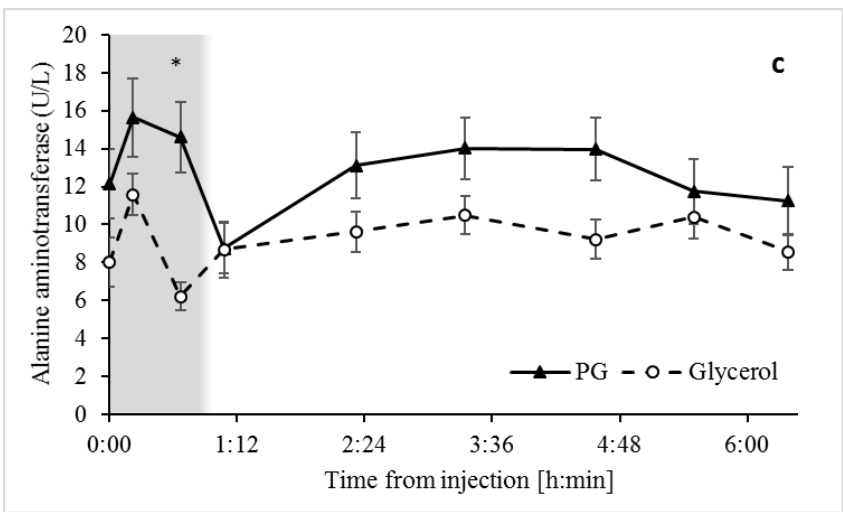
Figure 6. Liver and tissue damage biomarkers in response to intravenous treatments with PG and glycerol. ( a ) Lactate dehydrogenase (LDH) increased to a greater extent in response to PG compared to glycerol ( p < 0.0001). This difference extended only to the first 40 min after treatment (shaded) and not to the entire sampling time. Analyses reveal the effects of Time and Treatment × Time interaction (Table 1). SEM = 25.3. A similar pattern of change was observed for ( b ) aspartate aminotransferase (AST), which also increased in response to PG for the first 40 min after treatment (shaded) ( p < 0.01), with a fixed effect of Time and Treatment × Time interaction (Table 1). SEM = 10.7. ( c ) Alanine aminotransferase (ALT) also increased in response to PG during the first 40 min after treatment ( p < 0.0005), with a fixed effect of Time and Treatment × Time interaction. SEM = 1.3. Graphs of ( a ), ( b ), and ( c ) represent mean ± SE values. p -values are considered significant if lower than the Bonferroni-corrected significance (a = 0.00625). * Significant difference.